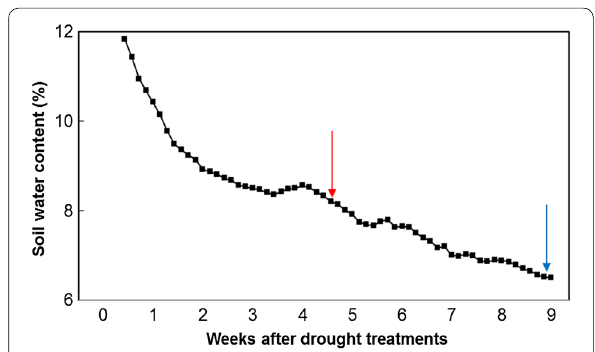
Fig. 1 Soil water content (%: 10‑cm depth) over time after stress treatment. Red arrows indicate times of mild drought; blue arrow, moderate